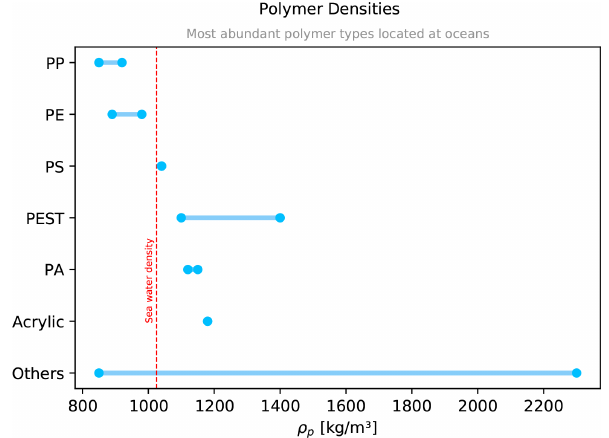
Figure 1. Polymer densities for the most abundant microplastics identified in water bodies (Erni-Cassola et al.,